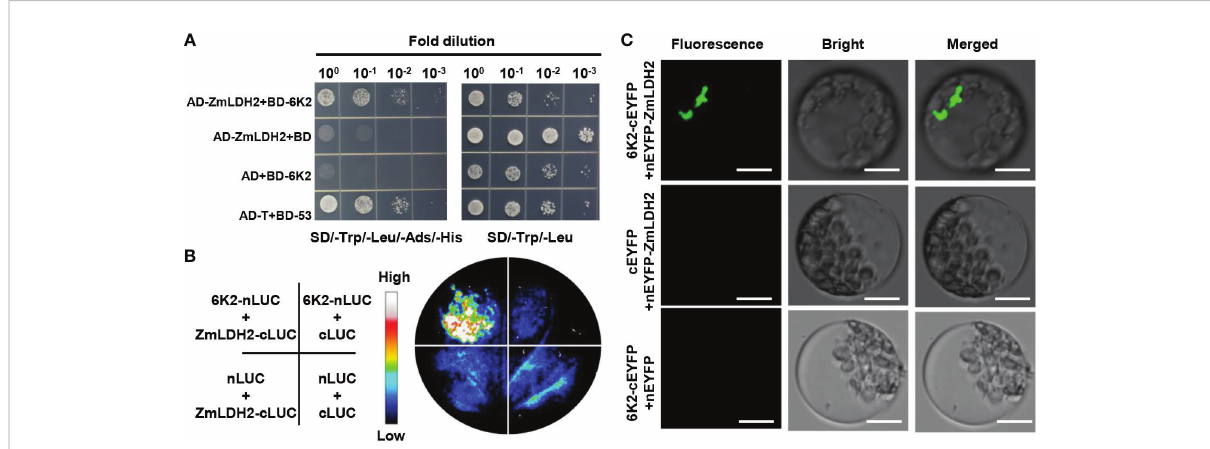
FIGURE 5 SCMV-encoded 6K2 interacts with ZmLDH2 in vitro and in vivo . (A) Analysis of the interaction between 6K2 and ZmLDH2 by yeast two-hybrid assays. Serial dilutions of yeast cells co-transfected with two recombination vectors were plated on SD – Trp – Leu – His – Ade medium. Yeast cells co-transfected with pGADT7-T (AD-T) and pGBKT7-p53 (BD-53) were used as positive controls. (B) Analysis of the interaction between 6K2 and ZmLDH2 by luciferase complementation imaging (LCI) assays. The Agrobacterium strains carrying the indicated constructs were in fi ltrated into N. benthamiana leaves. Luciferase activities were recorded 3 days after in fi ltration. (C) Biomolecular fl uorescence complementation (BiFC) analysis of the interaction between 6K2 and ZmLDH2. ZmLDH2 and 6K2 fused to N or C-terminus of YFP were transiently co-expressed in maize protoplasts. Confocal analysis was performed at 14 h post transfection. Representative results of at least three independent experiments are shown. Scale bars = 20